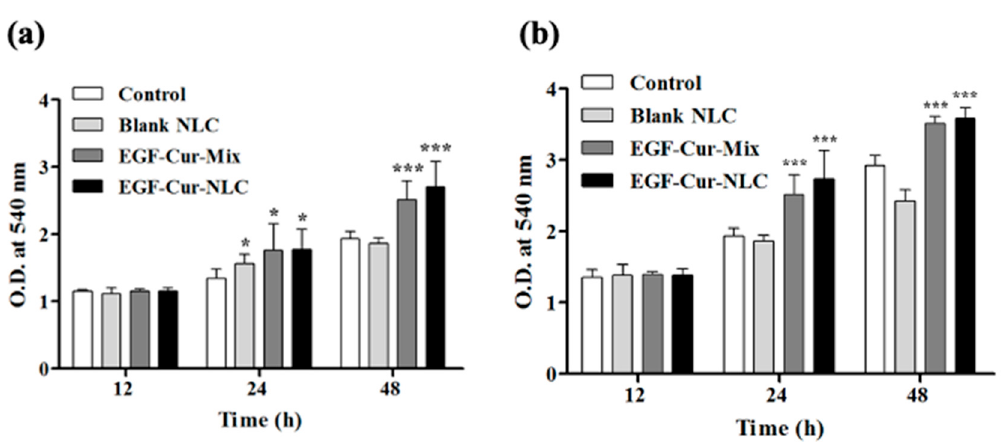
Figure 4. Cell proliferation assay for ( a ) NIH 3T3 fibroblast and ( b ) HaCaT keratinocytes using the MTT assay. The data are shown as mean O.D. ± SD ( n = 6); * p < 0.05 and *** p < 0.001 were considered significant compared to the control.